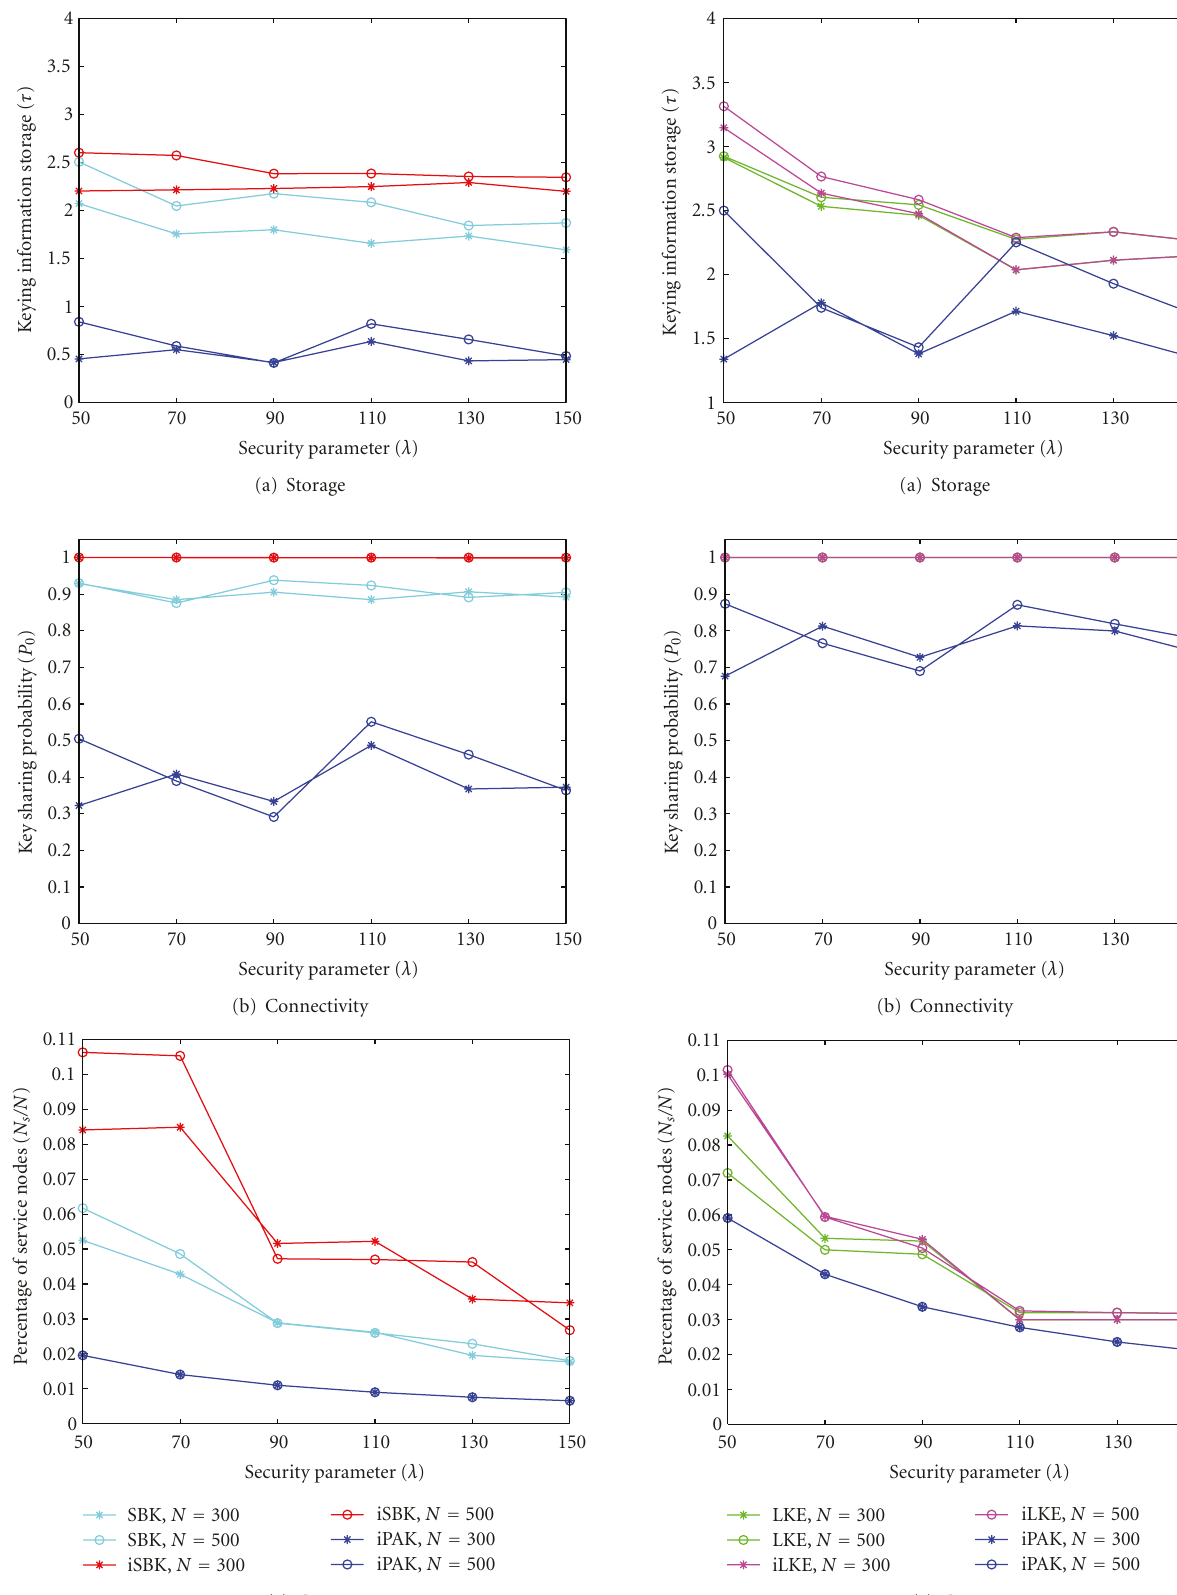
≤ λ ): Figure 5: Test 2. iPAK versus LKE (iPAK: ρ = π , N T 0 Comparison on storage, connectivity, and